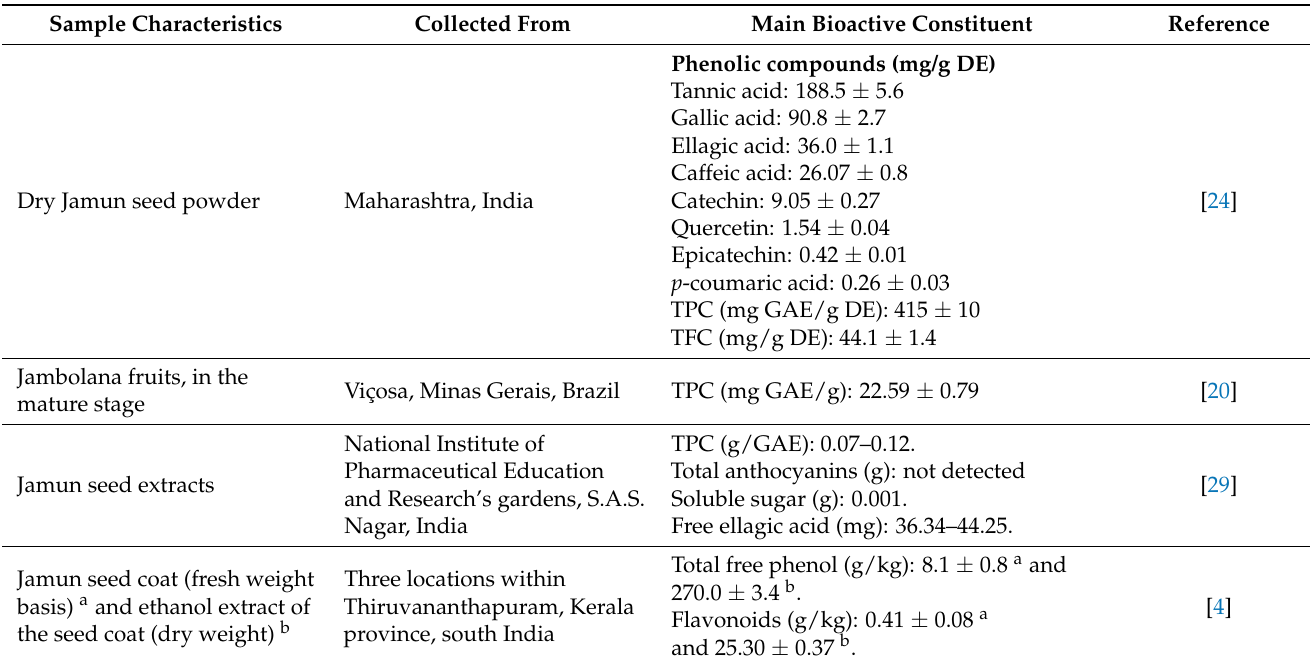
Table 1. The major bioactive constituents of Jamun